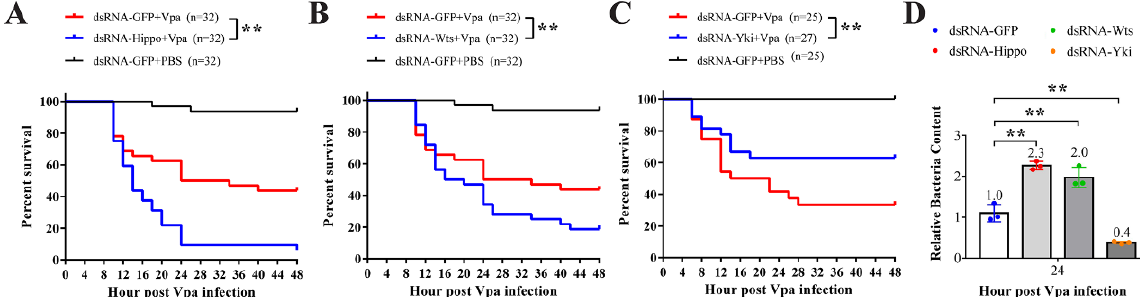
Figure 5. The implication of the Hippo pathway in Vibro infection. The survival rates of V. parahaemolyticus- infected shrimp after silencing Hippo ( A ), Wts ( B ), and Yki ( C ) were statistically analyzed. ( D ) The V. parahaemolyticus bacterial load in gills was detected by qPCR. ** p < 0.01 by two-tailed unpaired Student’s t -test.